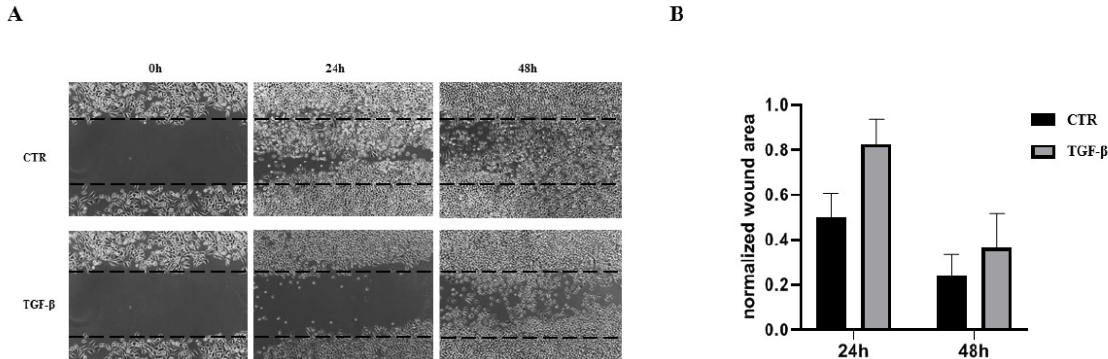
Figure 2. ( A ) Migration assay of cholangiocyte cells treated with TGF- β at the dose of 10 ng/mL compared to the control cells cultured in medium with 1% FBS. ( B ) Bar graphs represent the normalized wound area calculated in two regions of each well at random ( n = 3). Statistical analysis showed no significant differences between different conditions. Table 1. Identified differentially expressed proteins in TGF- β -treated cholangiocytes. The table below reports mean protein abundances and degrees of variation (evaluated as fold change) with respect to the control for TGF- β -treated cholangiocytes at 24 h and 48